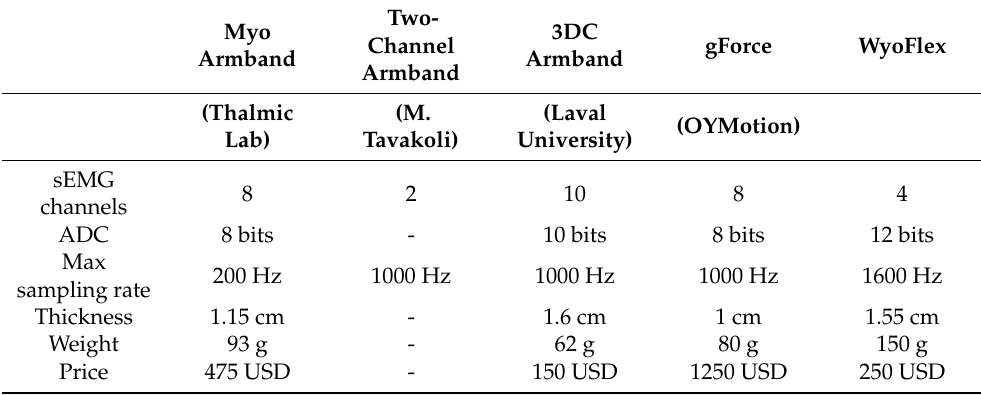
Table 1. Characteristics of sEMG